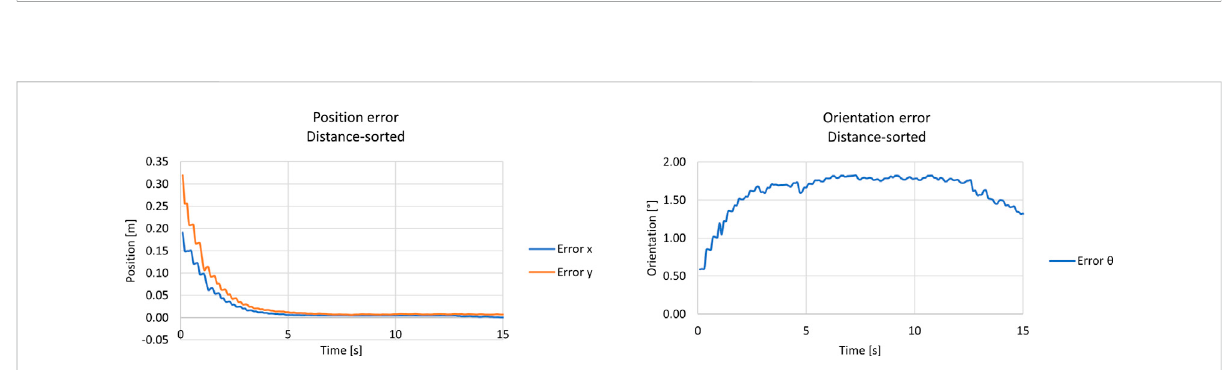
FIGURE 17 Results from the kidnapped robot test with the distance-sort approach and without Mahalanobis fi lter. The left graph shows the position error, and the right graph the orientation